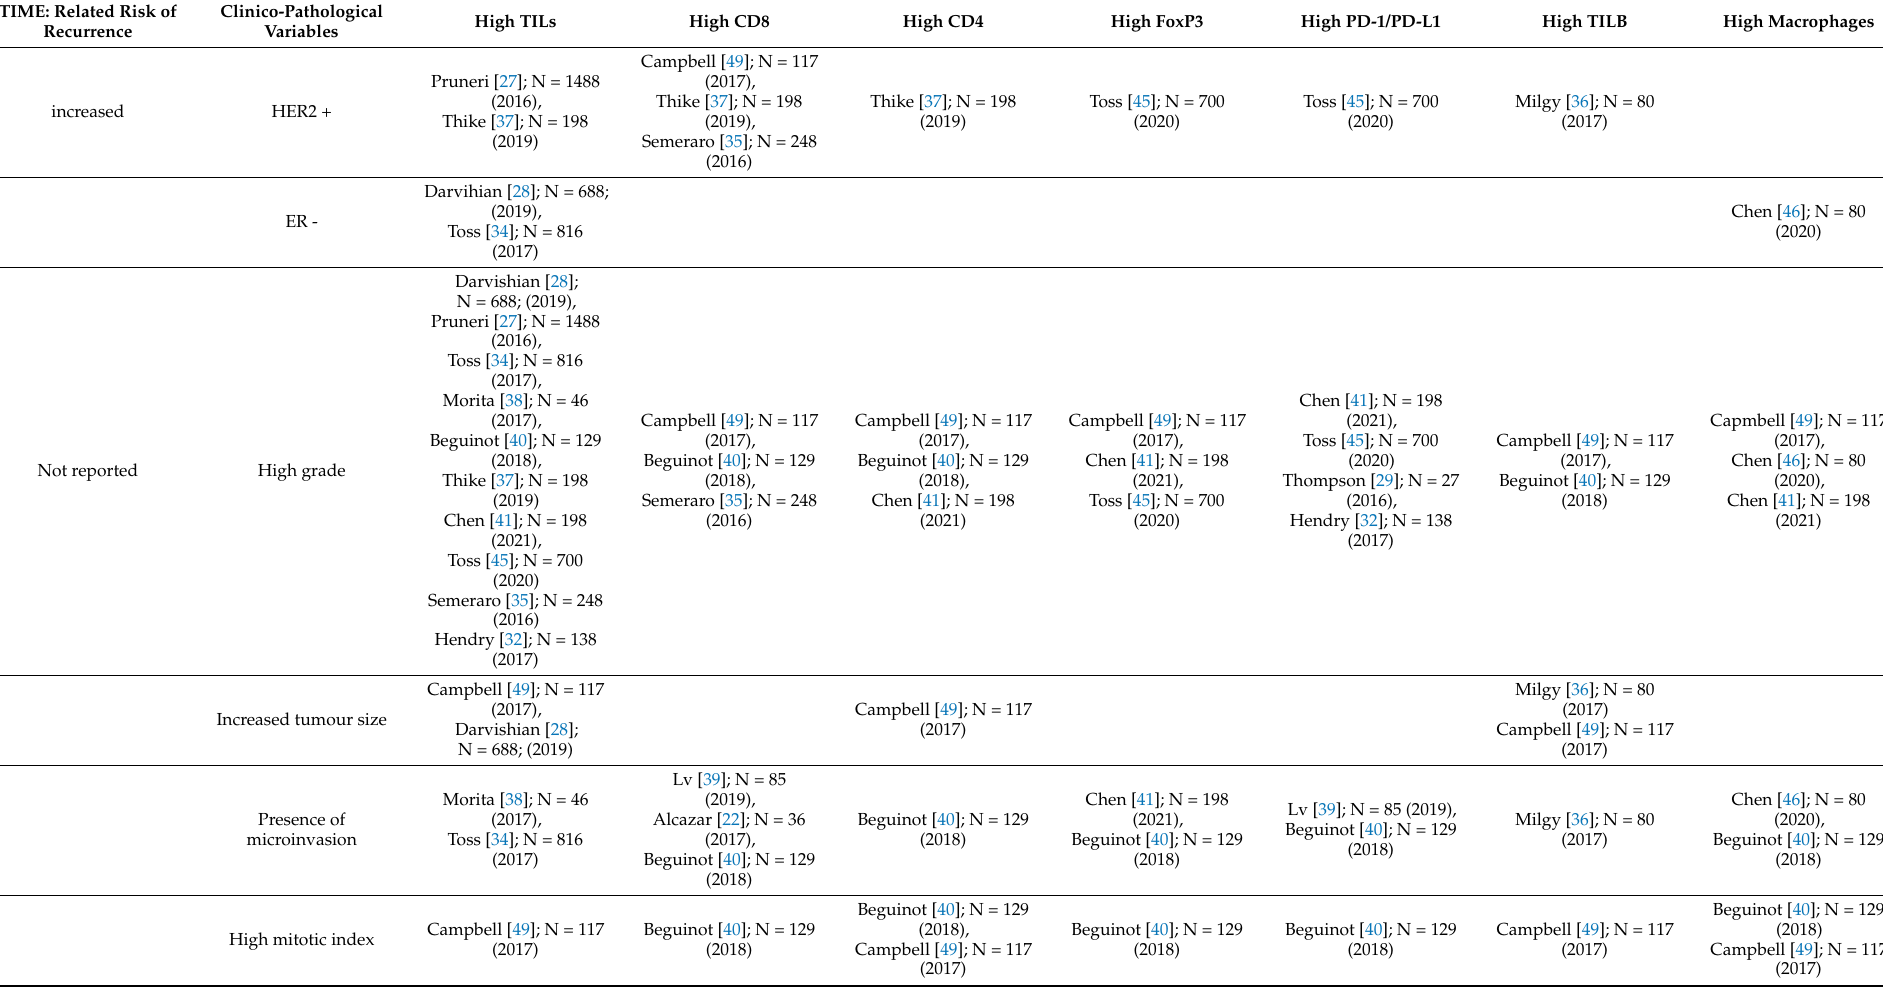
Table 1. Reported associations between components of TIME, clinicopathological variables, and risk of recurrence. TIME—tumour immune microenvironment; ER— estrogen receptor; HER2—Human Epidermal Growth Factor Receptor 2; TILs—tumour-infiltrating lymphocytes; PD-1/PD-L1—Program Death Receptor/Ligand; TILB—tumour-infiltrating lymphocytes B; N—cohort size and number of reference in